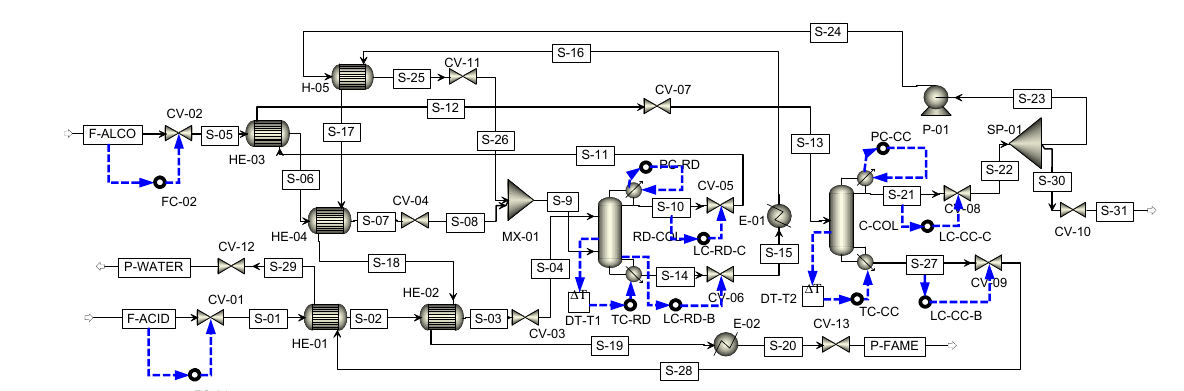
Figure 7. Process flow diagram with control scheme used in Case I (composition control and feed ratio control not in- cluded).